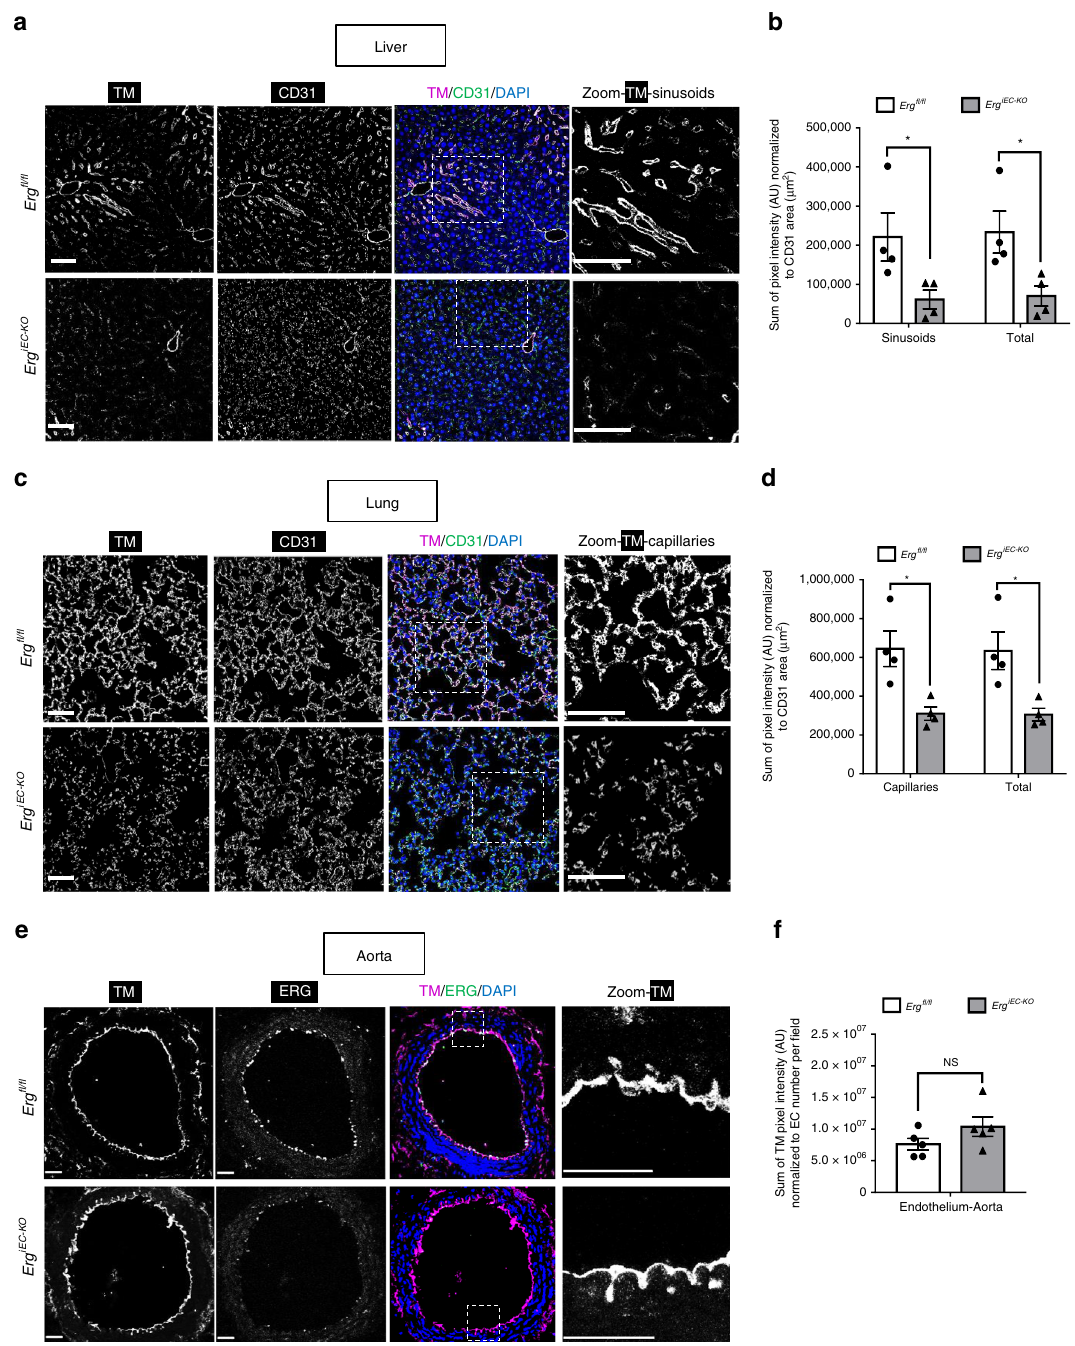
Fig. 8 ERG regulates thrombomodulin expression speci fi cally in microvascular beds. a , c Representative image by immuno fl uorescence and b , d quanti fi cation of TM expression (magenta) in a , b liver and c , d lung sections from Erg fl / fl and Erg iEC-KO mice 30 days after tamoxifen injection; tissues are co-stained for CD31 to visualise blood vessels (green); nuclei are identi fi ed by DAPI (blue). Scale bar 50 µ m. Quanti fi cation represents the ratio between the sum of pixel intensity for TM signal (arbitrary unit, A.U.) and CD31 area ( µ m 2 ) (re fl ecting vascular coverage) ( n = 4 mice per genotype). e Representative immuno fl uorescence image and f quanti fi cation of endothelial TM expression (magenta) in aorta sections from Erg fl / fl and Erg iEC-KO mice 45 days after tamoxifen injection; tissues are co-stained for ERG (green); nuclei are identi fi ed by DAPI (blue). Scale bar 50 µ m. Quanti fi cation represents the ratio between the sum of pixel intensity for TM signal (arbitrary unit, A.U.) and the number of EC per fi eld identi fi ed by DAPI ( n = 5 mice per genotype). All graphical data are mean ± s.e.m., * P < 0.05, ** P < 0.01, *** P < 0.001, Student ’ s t -test. Source data are provided as a Source Data fi